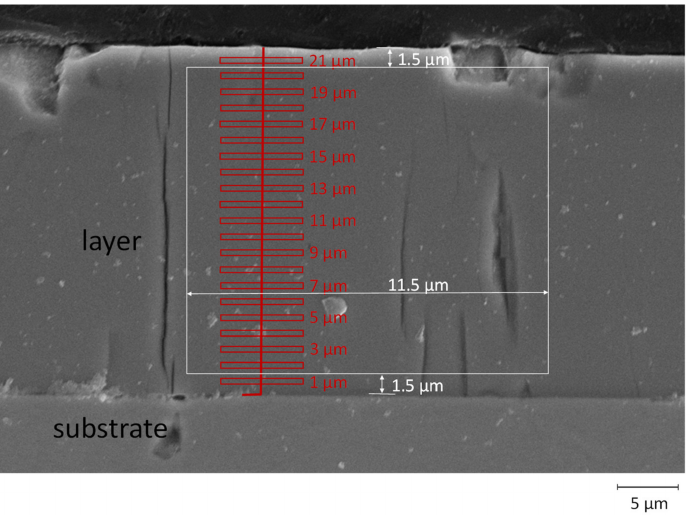
Figure 2. Method of area analysis (white) and method of point-like analyses (red) of EDXS